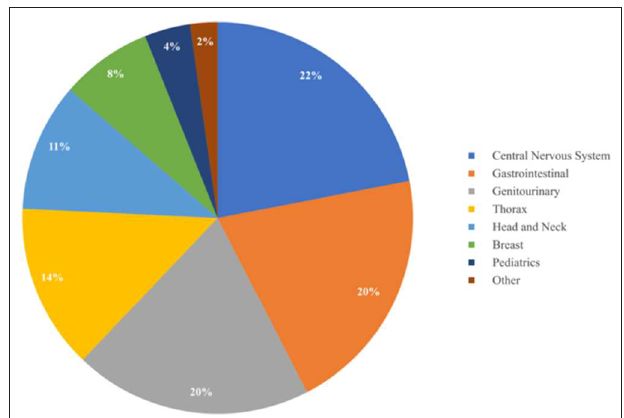
FIGURE 3 | Disease site breakdown of patients receiving PBT.